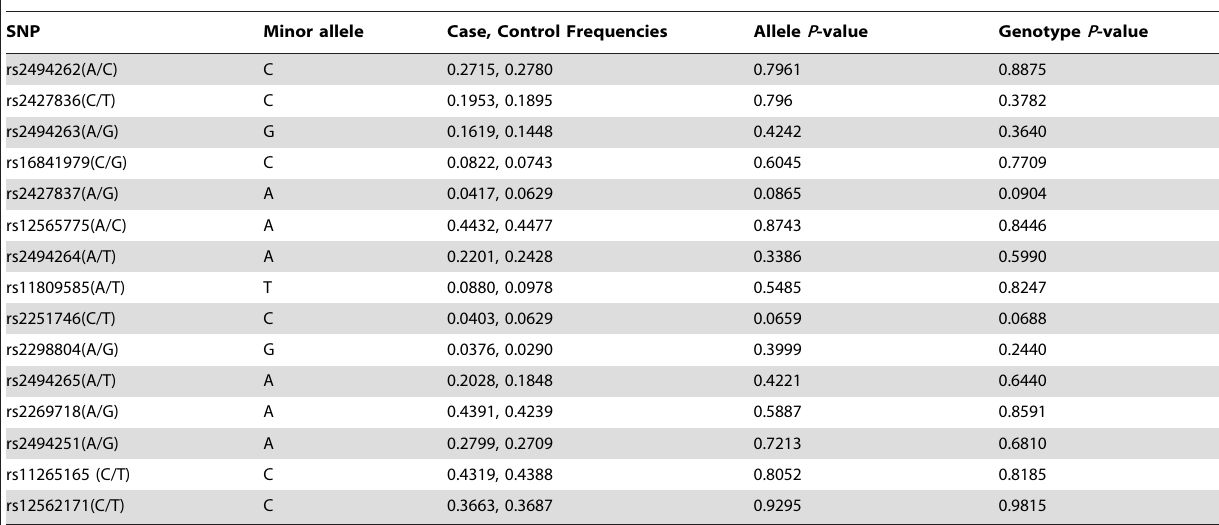
Table 2. Allele and genotype frequencies and AR susceptibility.